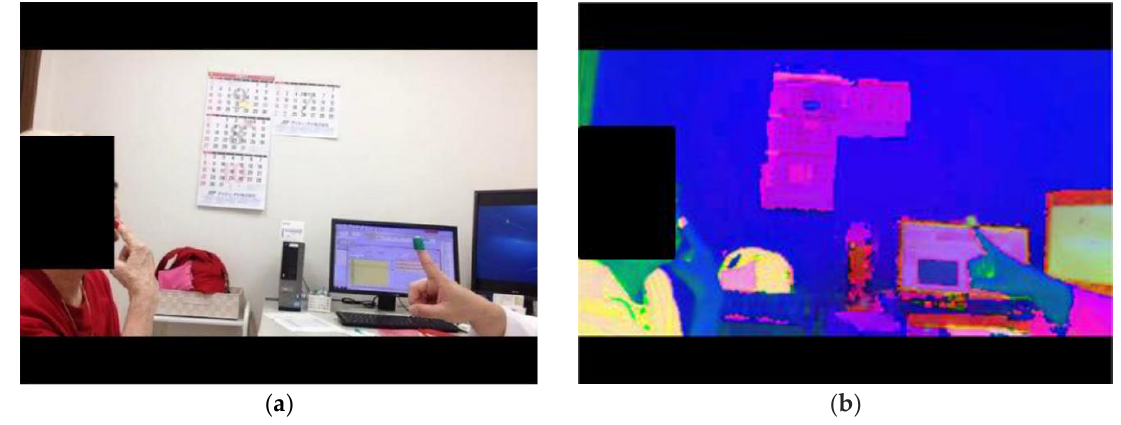
Figure 3. ( a ) Input image. ( b ) The converted HSV image for the input image.